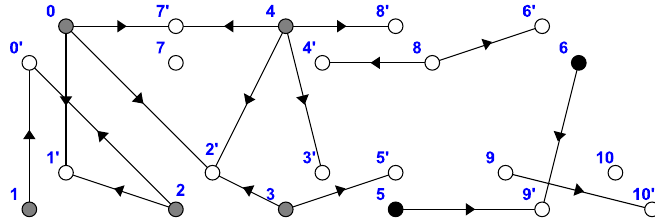
Figure 7: Result of block separation for the digraph of Figure